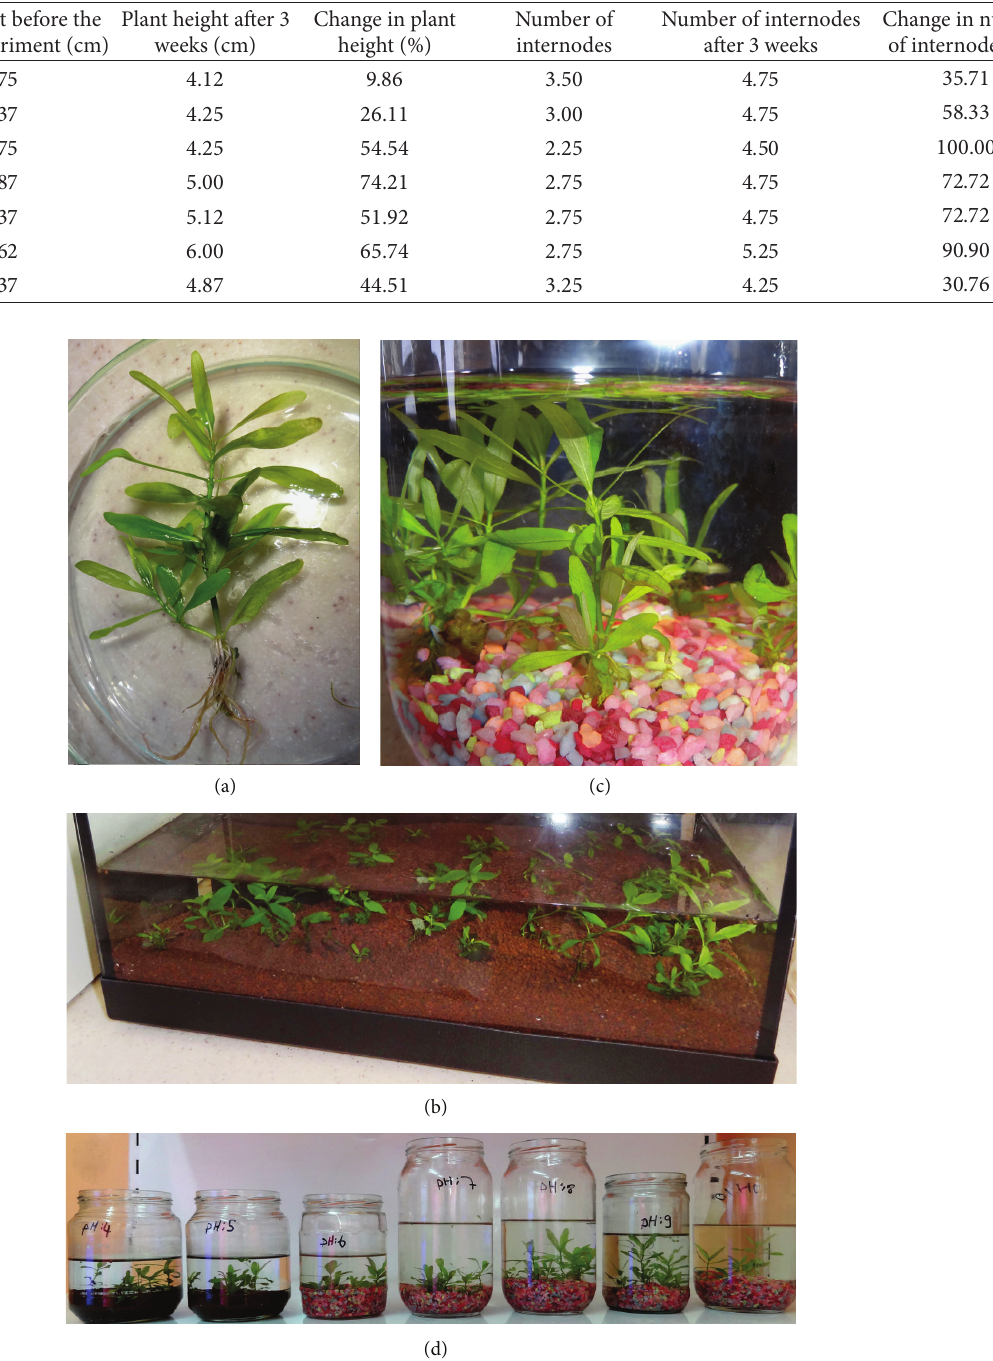
Figure 2: Rooting and acclimatization of in vitro regenerated plants of H. polysperma : (a) rooted plantlets, (b) acclimatized plants in aquariums, and (c) plant acclimatization at different